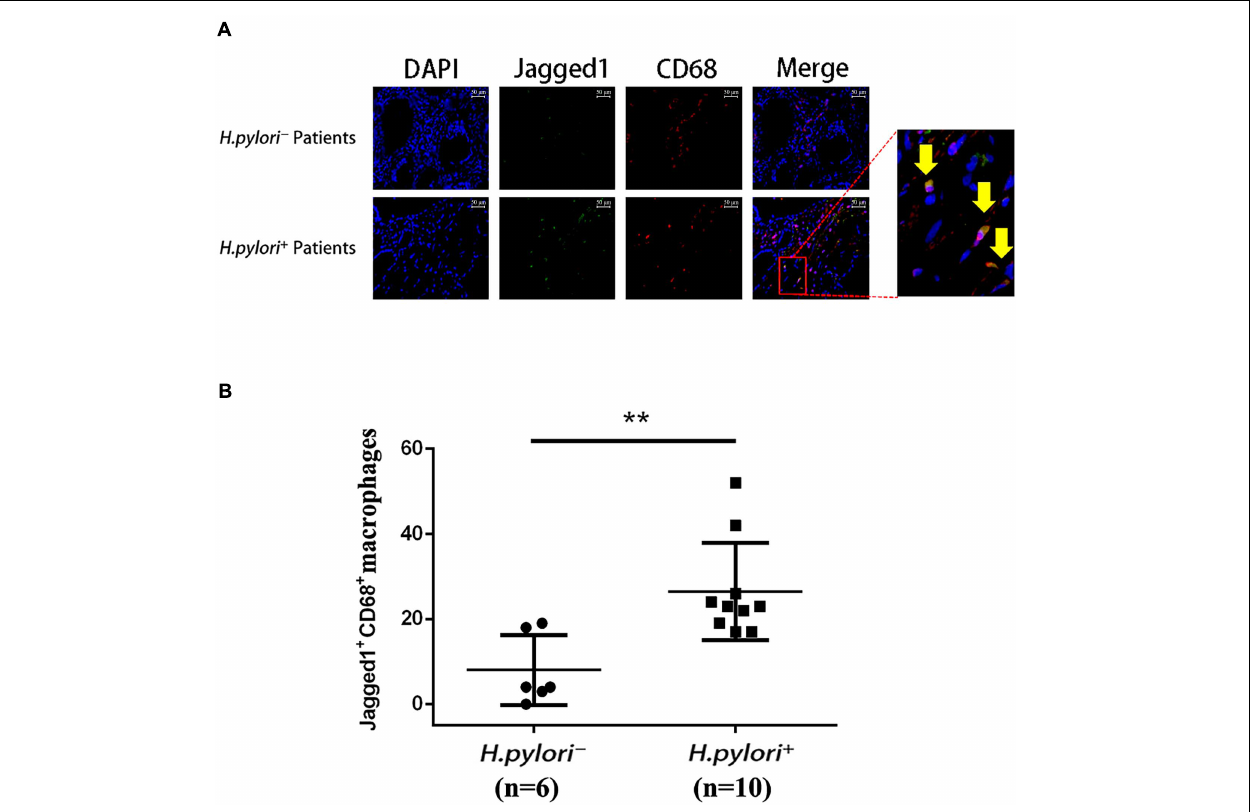
FIGURE 4 | Infiltration of Jagged1 + macrophages is higher in the gastric mucosa of H. pylori + gastritis patients. (A) Gastric mucosa tissues from H. pylori − and H. pylori + gastritis patients were double-immunofluorescent stained with anti-Jagged1 antibody (green) and anti-CD68 antibody (red), and nuclei were stained with DAPI (blue). A merged figure of macrophages is also shown. The yellow arrows indicate Jagged1 + CD68 + macrophages. Images were observed under a fluorescence microscope (200 × ). Representative images of the gastric mucosa of H. pylori − ( n = 6) or H. pylori + ( n = 10) gastritis patients were shown. The results represent three independent experiments. (B) Quantification of the number of CD68 + Jagged1 + cells in the gastric mucosa of H. pylori − or H. pylori + ( n = 10) gastritis patients. The data are presented as the mean ± SD of three independent images of each patient. ** p < 0.01.